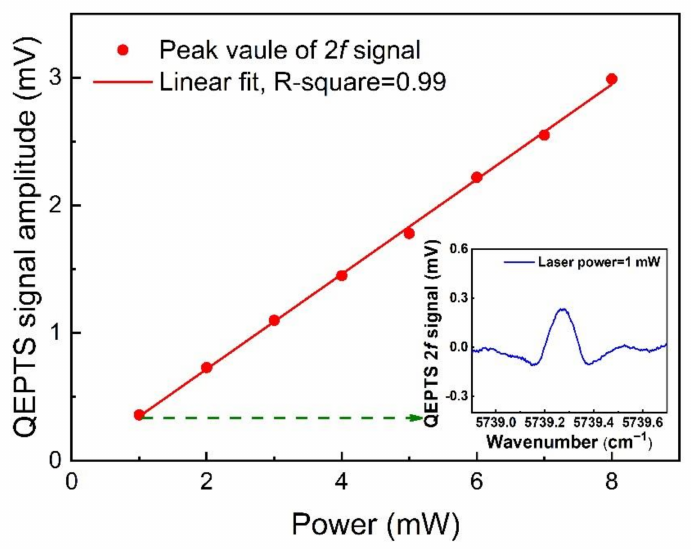
Figure 6. HCl-QEPTS sensor 2 f signal amplitude as a function of laser power at the optimized modulation depth. The insert shows QEPTS 2 f signal with laser power of 1 mW.